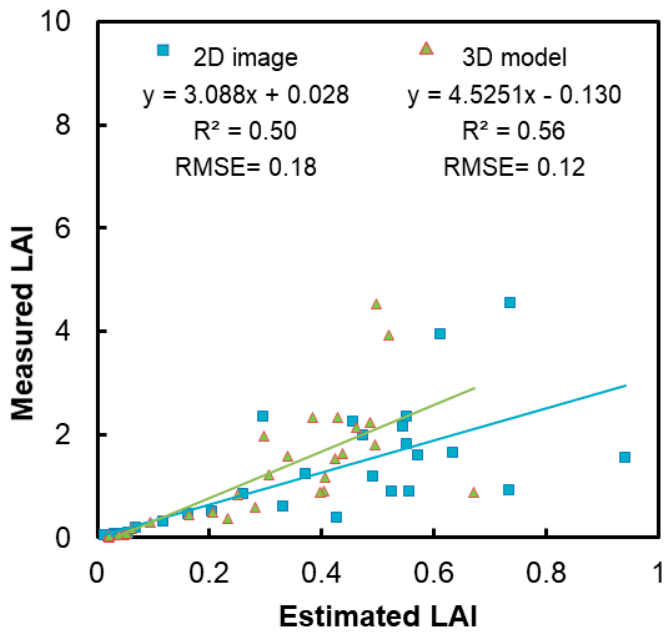
Figure 8. The comparison of sweet potato unmanned aerial vehicle (LAI) between measured and estimated values.